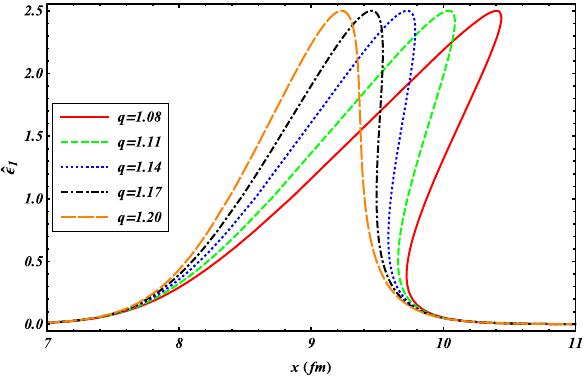
Fig. 6 Solutions at t = 15 f m for different Tsallis parameter values. A = 2 . 5, B = 0 . 5 f m , and T = 140 MeV